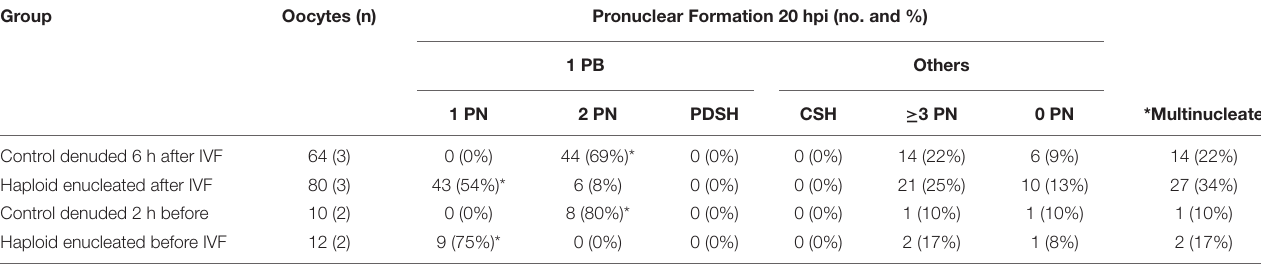
TABLE 2 | Formation of pronuclei of zygotes fixed at 20 h after insemination in control and enucleated oocytes manipulated either before or after insemination. Group Oocytes (n) Pronuclear Formation 20 hpi (no. and %) 1 PB Others 1 PN *Multinucleate Control denuded 6 h after